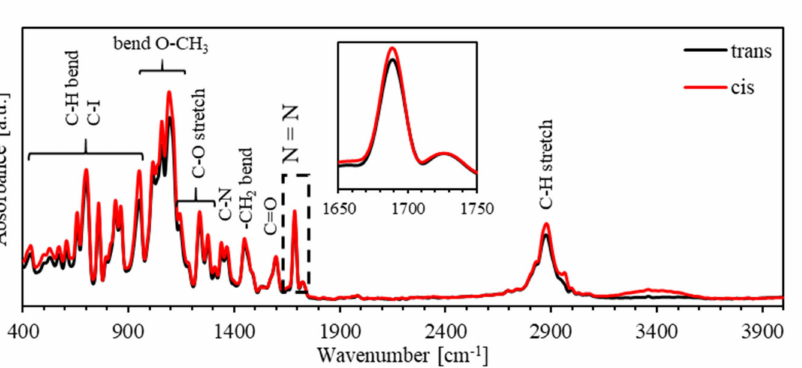
Figure 9. The FTIR spectra of trans - and cis -phases of (PEO-BDK-MR)/I 2 (1.0%) complex composite thin